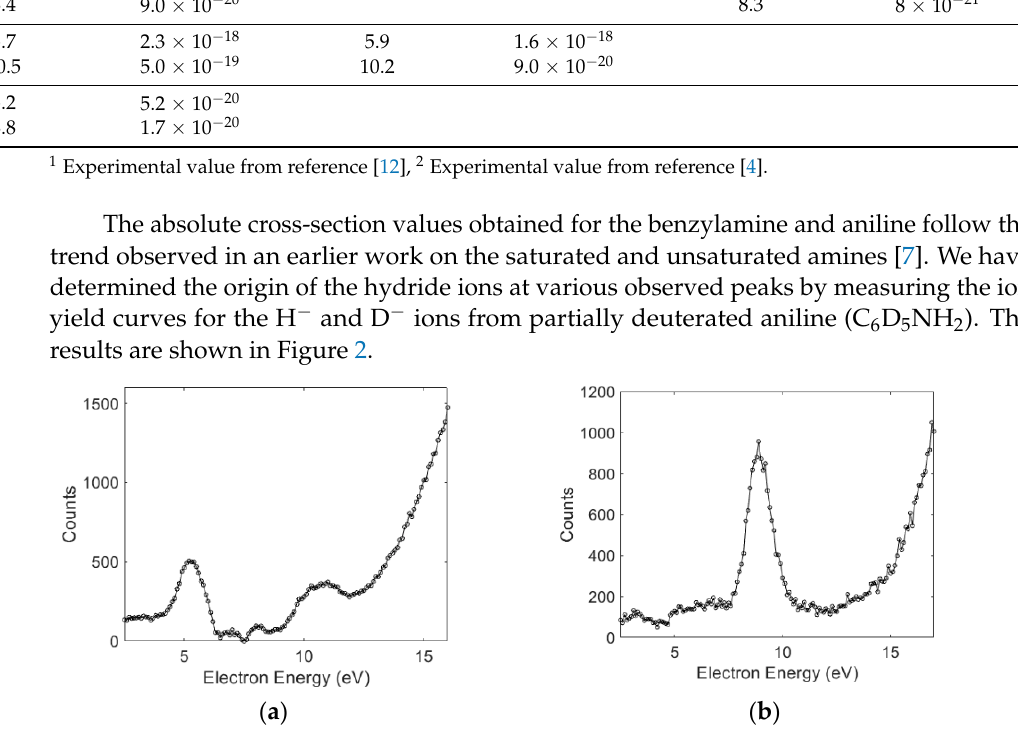
Figure 2. The ion yield curves as a function of electron energy for ( a ) H − and ( b ) D − ions from DEA to partially deuterated aniline (C 6 D 5 NH 2 ).